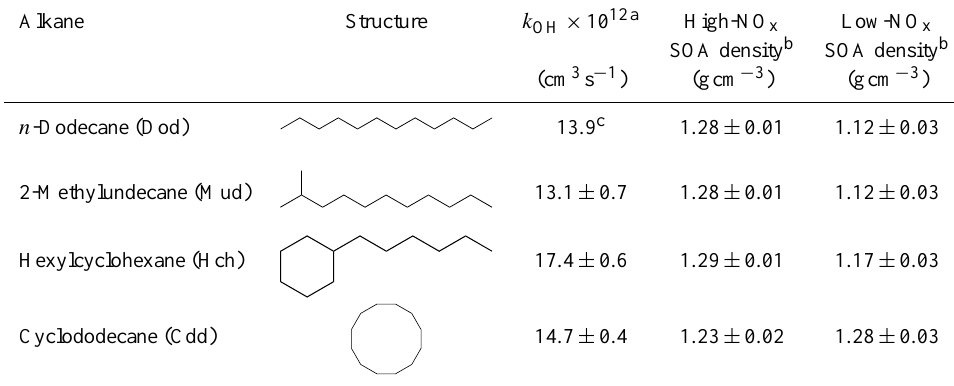
Table 1. SOA precursor and aerosol properties.